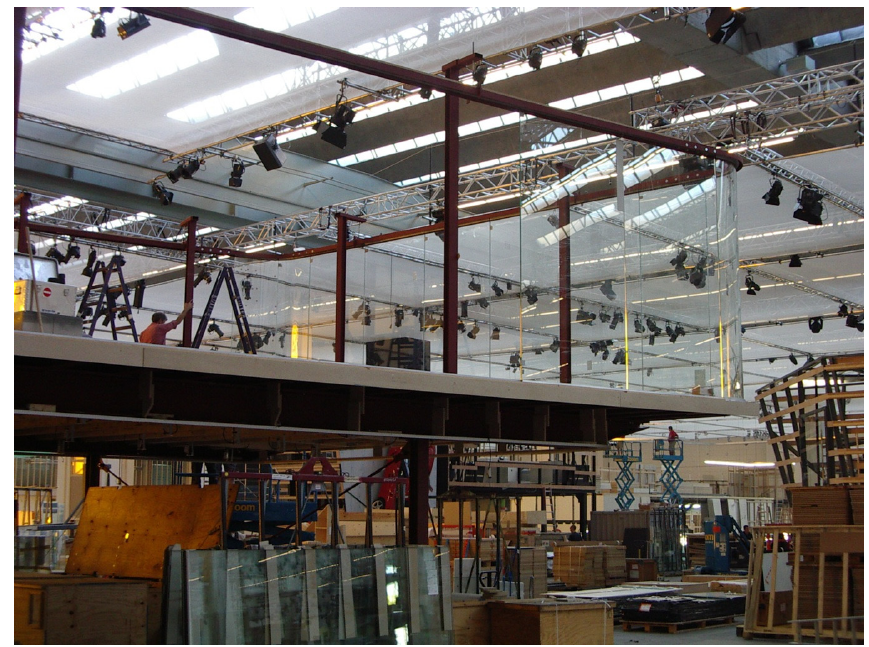
Figure 8: Steel frame with mike booms and mounted glasses at the narrow